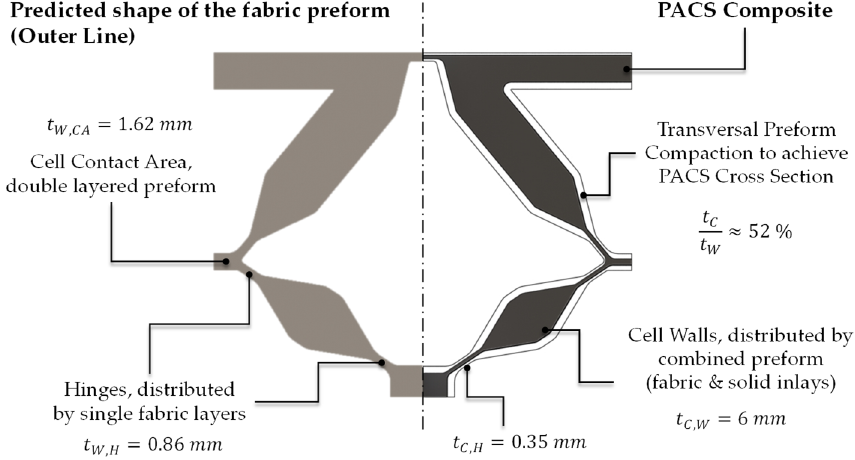
Figure 16. Cross section of the fabric preform and the consolidated PACS.